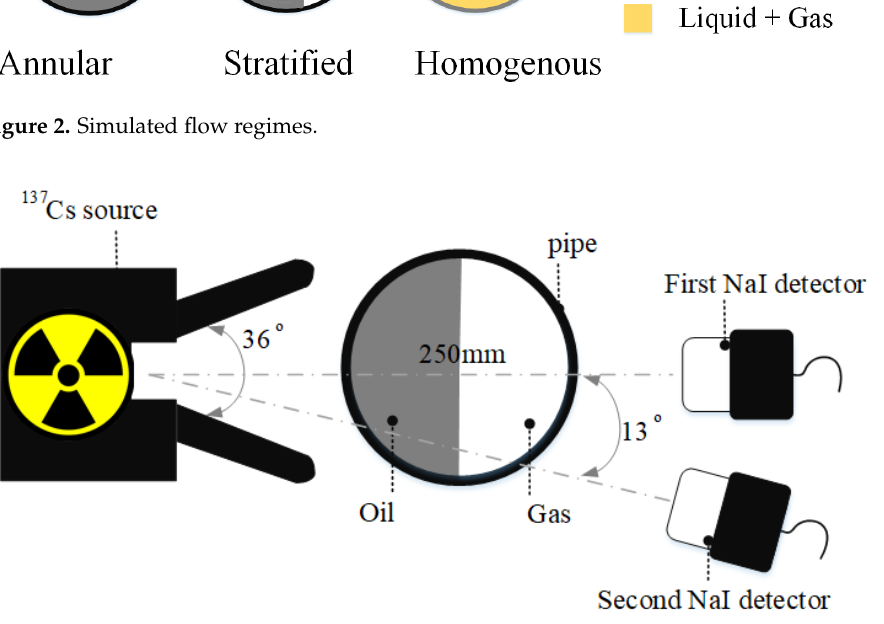
Figure 3. Model of the detecting system constructed using the MCNP code.